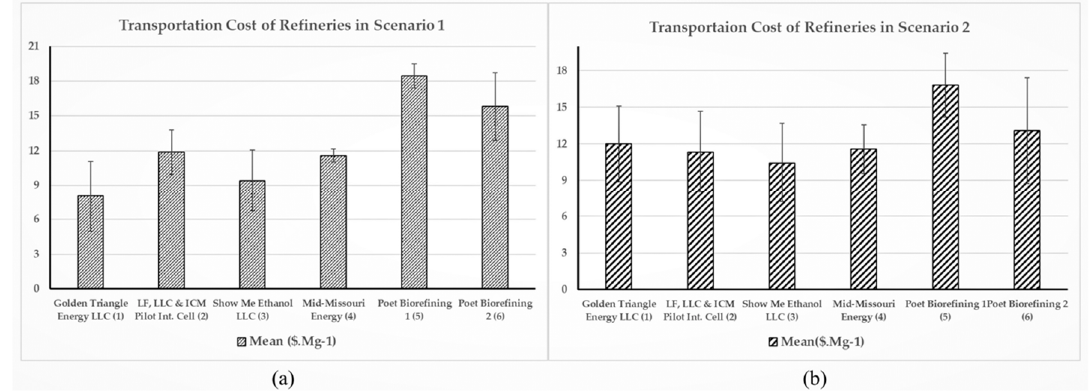
Figure 6. Transportation cost of refineries in scenarios. ( a ) in scenario 1, ( b ) in scenario 2.